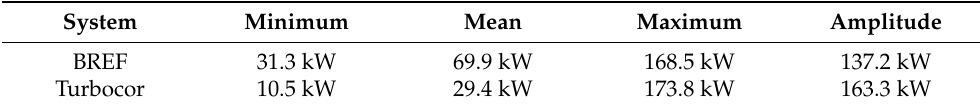
Table 7. Electric power consumption on 25–27 February